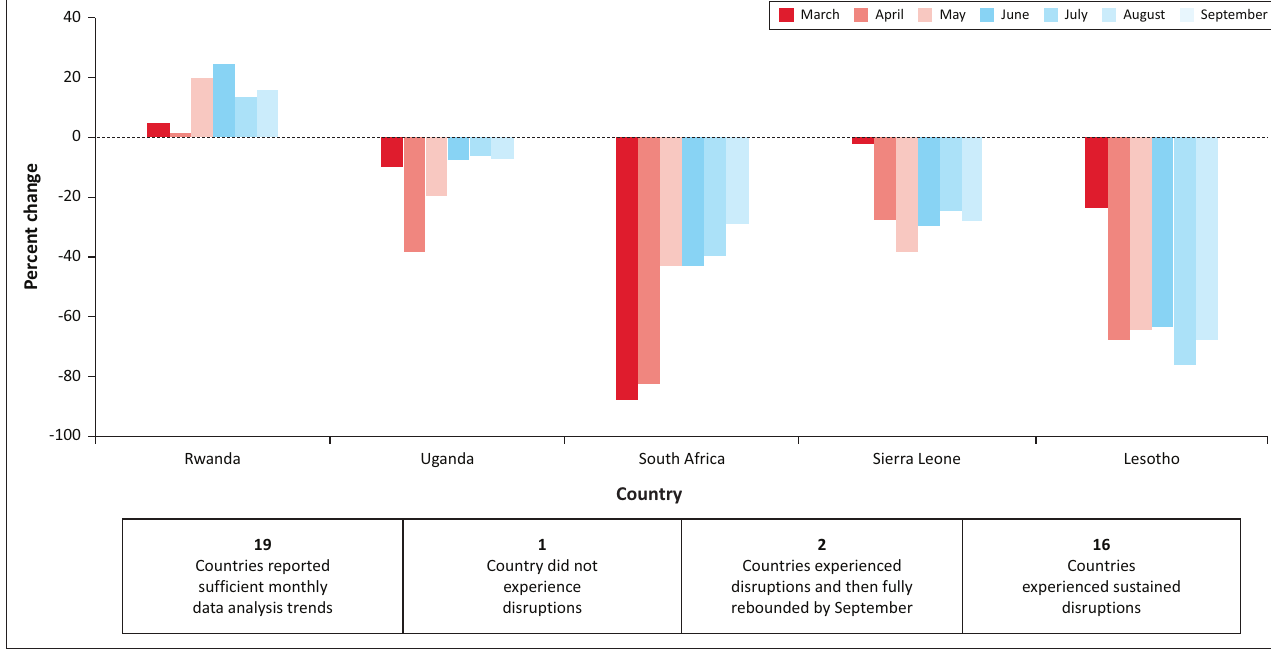
FIGURE 1: Change in the number of human immunodeficiency virus tests and results returned per month compared with baseline of selected countries in